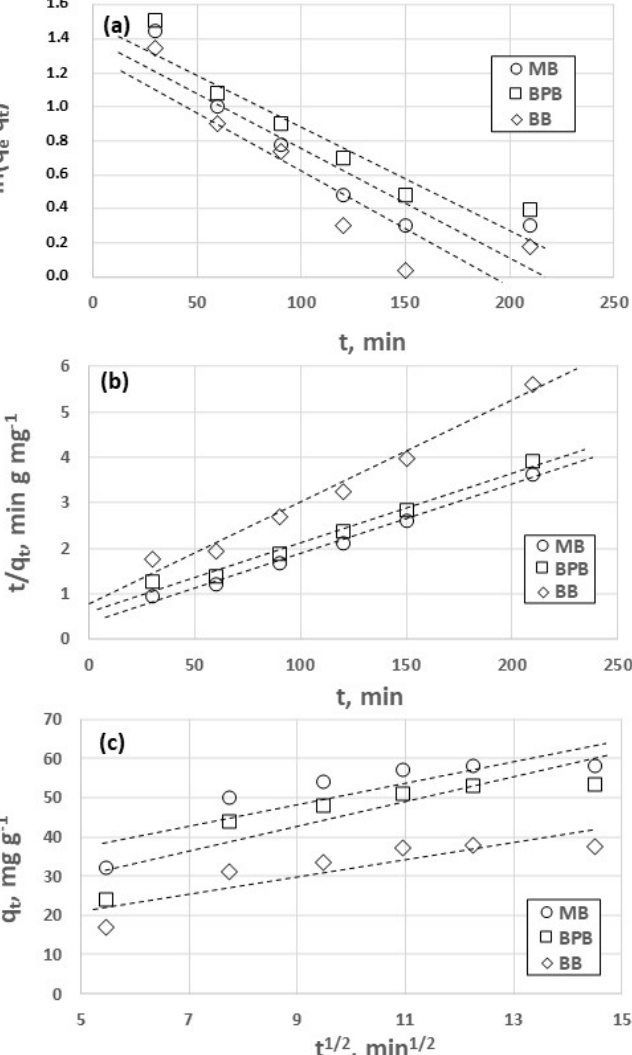
Figure 2. Kinetic models for adsorption of methylene blue (MB), bromophenol blue (BPB), Coomassie brilliant blue (BB) on chitosan hydrogel. S/L ratio = 1/100, contact time = 120 min. Models: PFO ( a ), PSO ( b ), intraparticle diffusion ( c ).